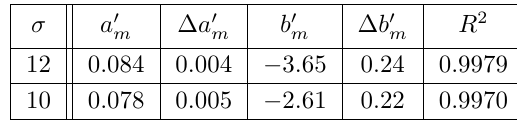
Table 10 . Parameter of the fit (4.3) for two values of the resonant parameter σ = 12 , 10 and bath temperature exponent α R 2 is the R-squared goodness of fit parameter.